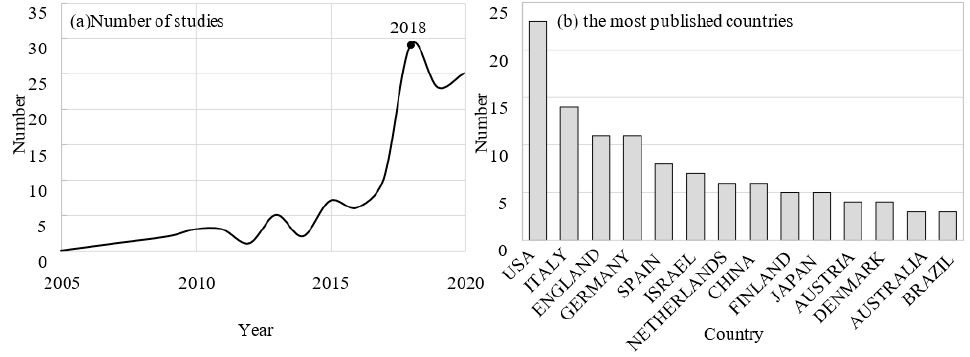
Figure 2. The trend of studies and the most published countries on RES research from 2005 to 2020.